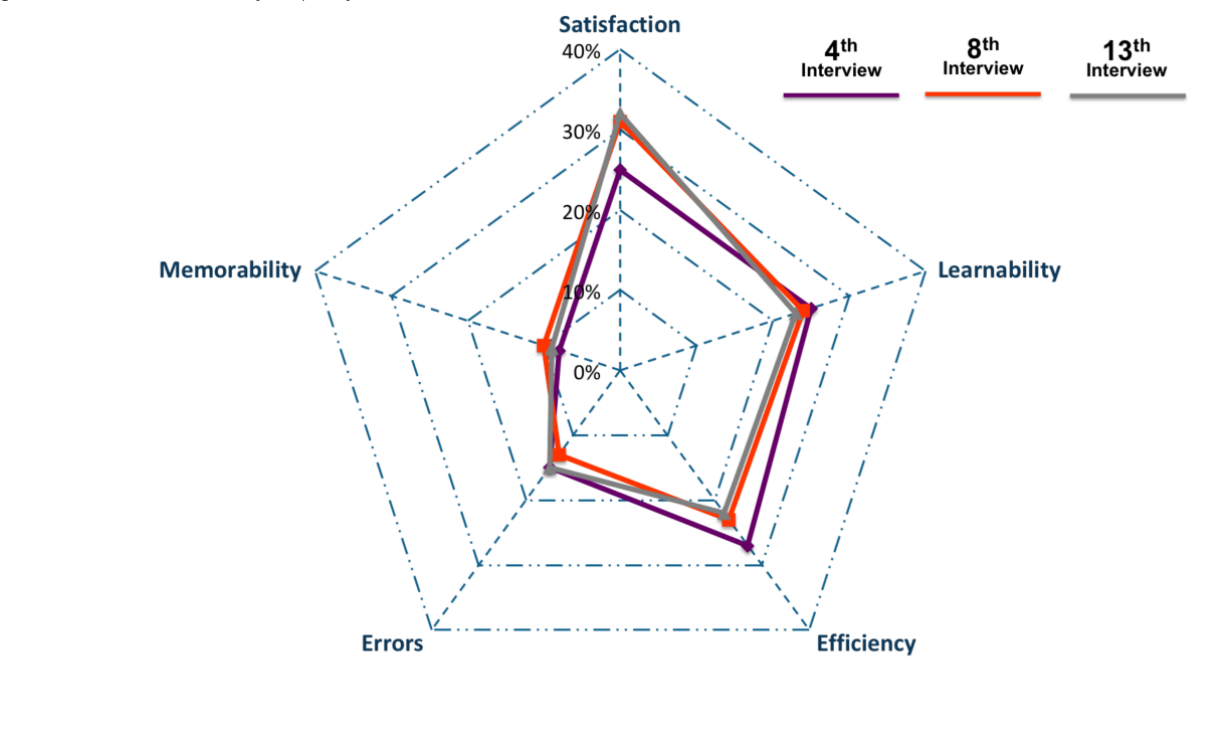
Figure 5. Second observation by frequency of